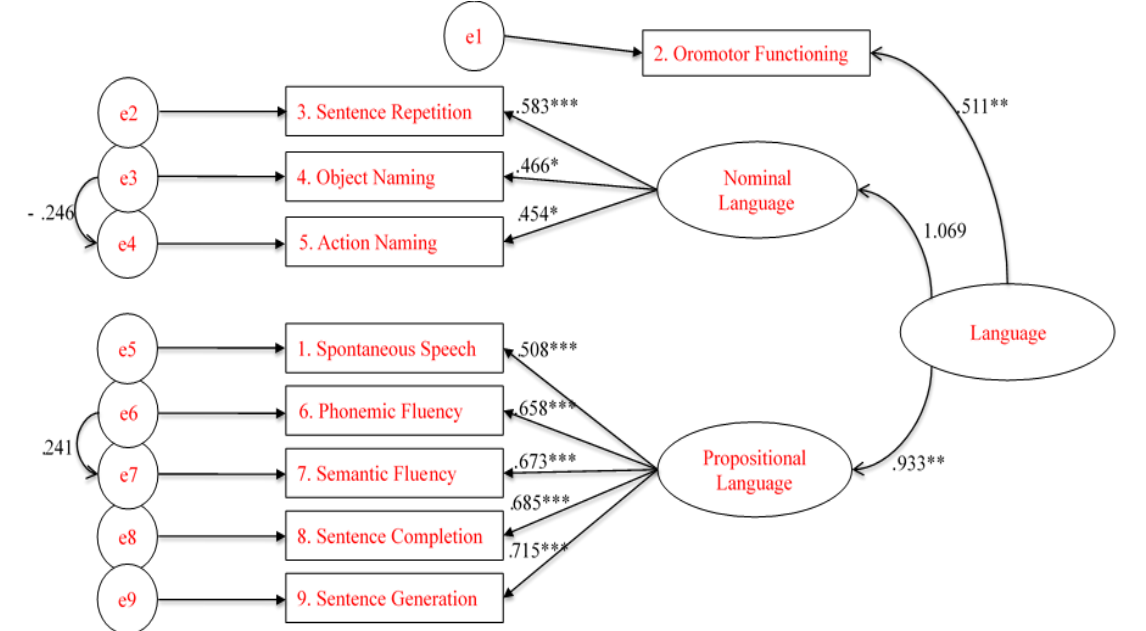
Figure 2. Schematic representation of the 3-factor Confirmatory Factor Analysis model (* p < 0.05, ** p < 0.01, *** p < 0.001).